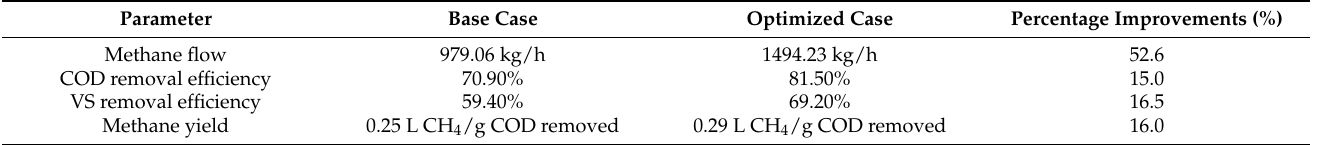
Table 8. Base case and optimized case